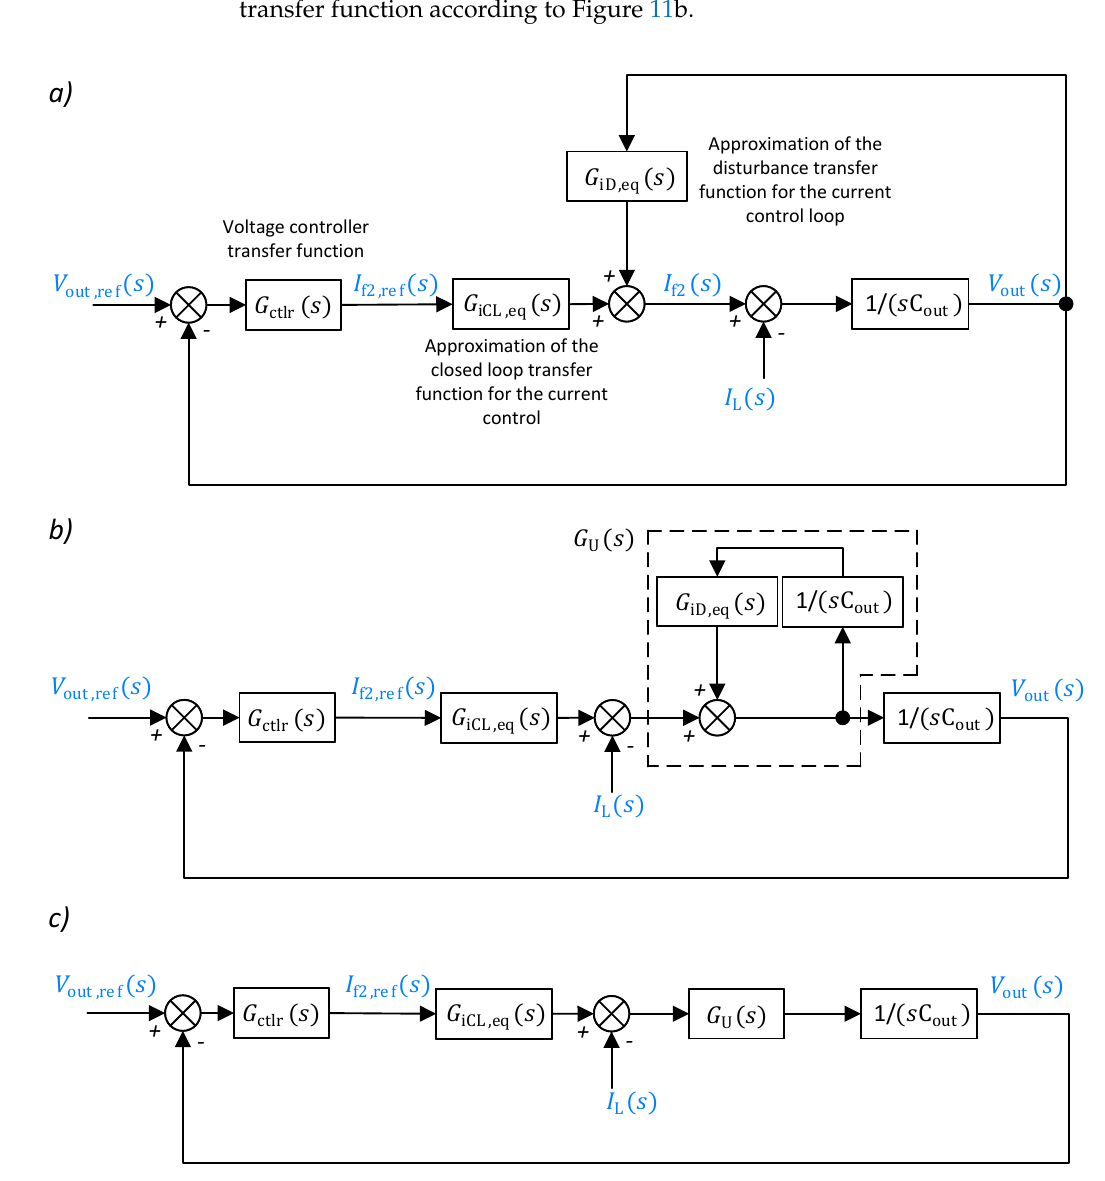
Figure 11. Block diagram of the voltage control loop: ( a ) diagram illustrating the real signal flow in the system, ( b , c ) consec- utive stages of the diagram